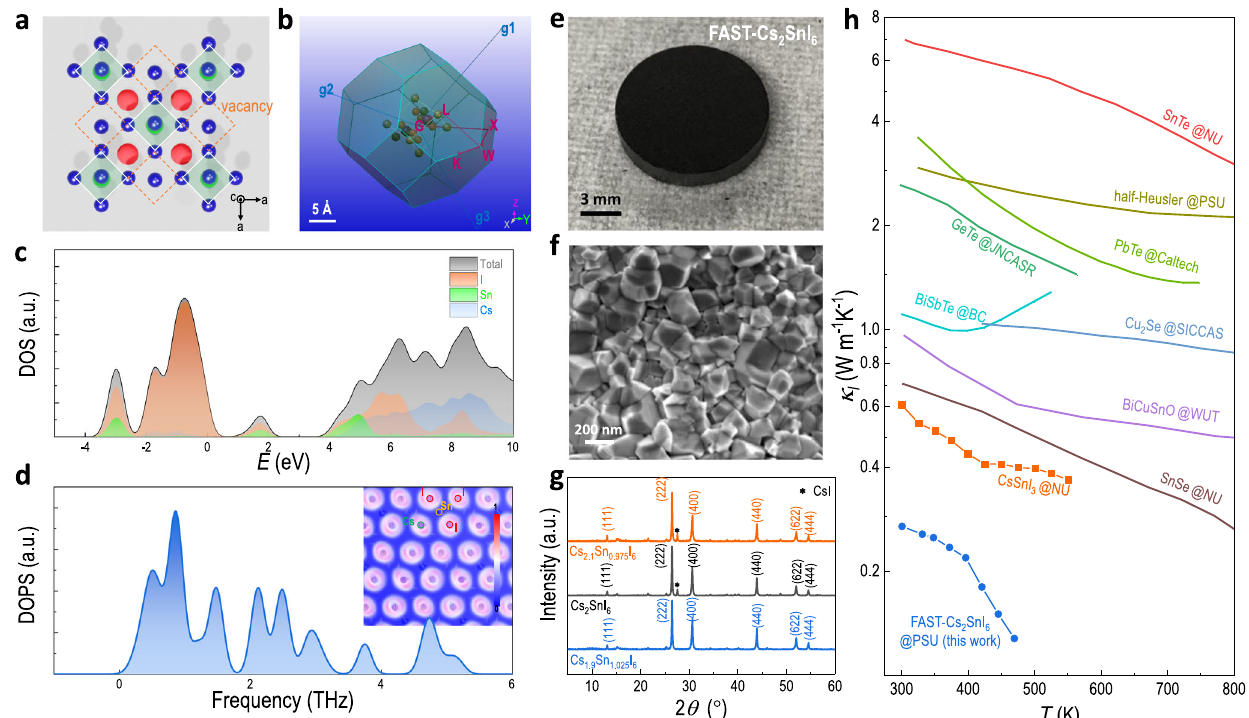
Fig.6|Exempli fi edapplicationofFAST-synthesizedhigh-qualityperovskitesin ultralow thermal conductivity of intrinsic n-type FAST-Cs 2 SnI 6 . a Lattice dia- gram of the vacancy-ordered feature. b The calculated Brillouin zone of the fcc latticeshowsthesymmetrypoints. c Totaldensityofstate(DOS). d Totaldensityof phonon state (DOPS) of Cs 2 SnI 6 . e Photo of a FAST-Cs 2 SnI 6 disk. f Corresponding